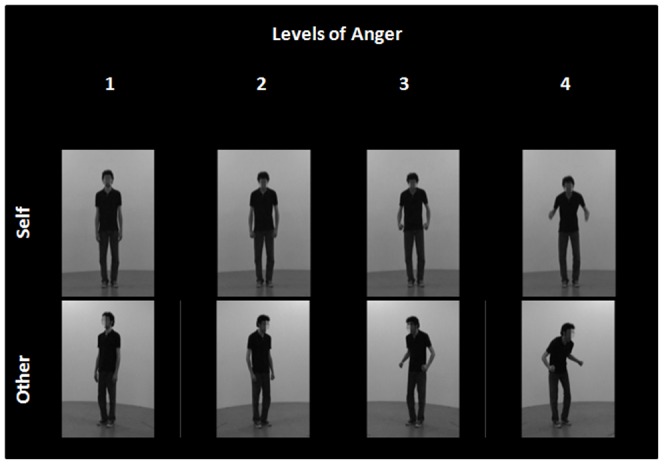
2*4 factorial design.Short movies of neutral (1), mild (2), moderate (3) and intense anger (4) oriented-to-Self and oriented-to-Other were presented.